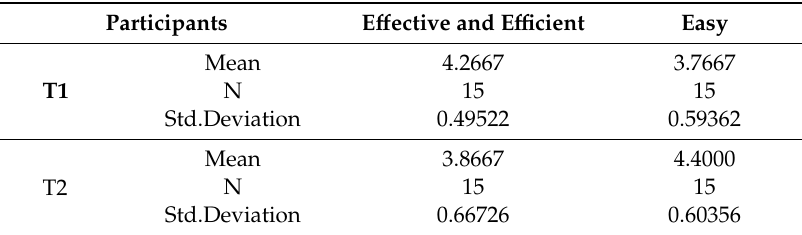
Table 9. T-test for